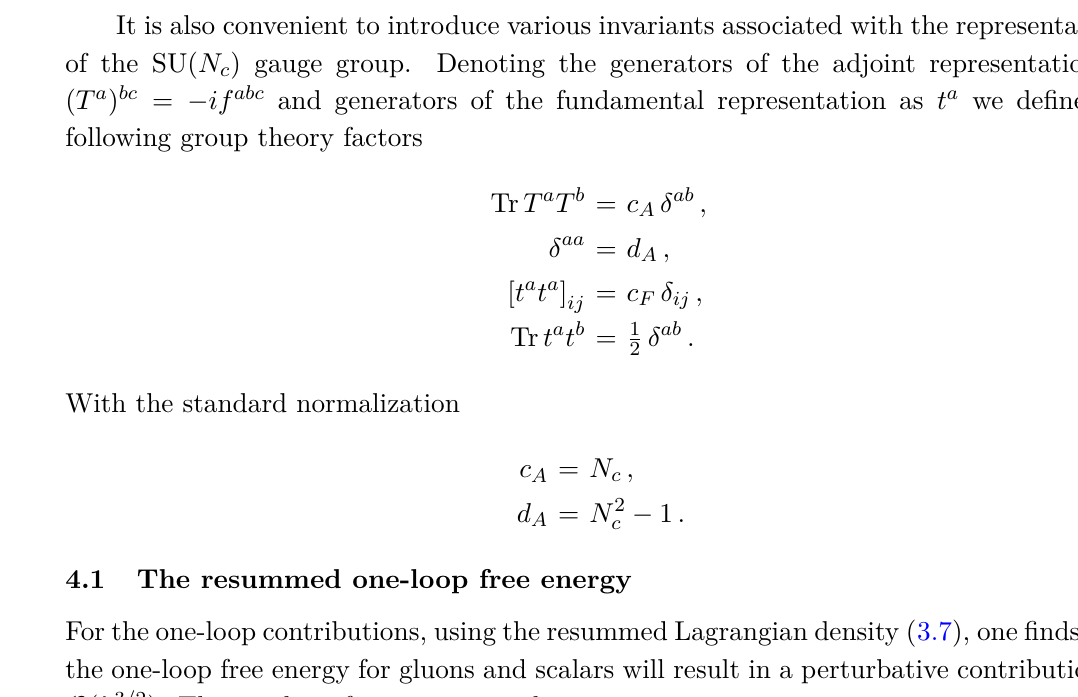
Figure 1 . One-loop diagrams contributing to the SYM 4 , 4 free energy. Spiral lines indicate gluons, solid lines indicate Majorana fermions (gauginos), dashed lines indicate scalars, and dotted lines indicate